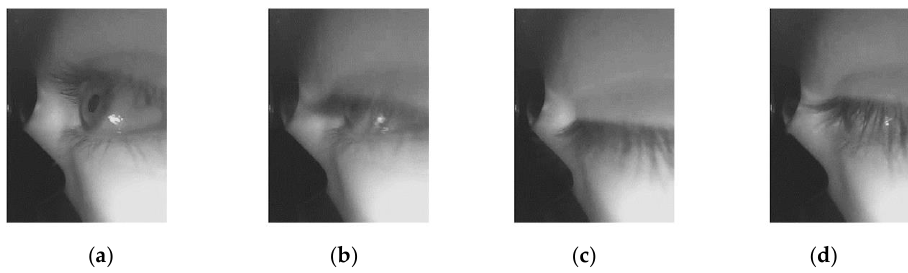
Figure 1. Eyeblink phases: ( a ) An open eye; ( b ) Closing phase; ( c ) Pause phase; ( d ) Reopening phase.